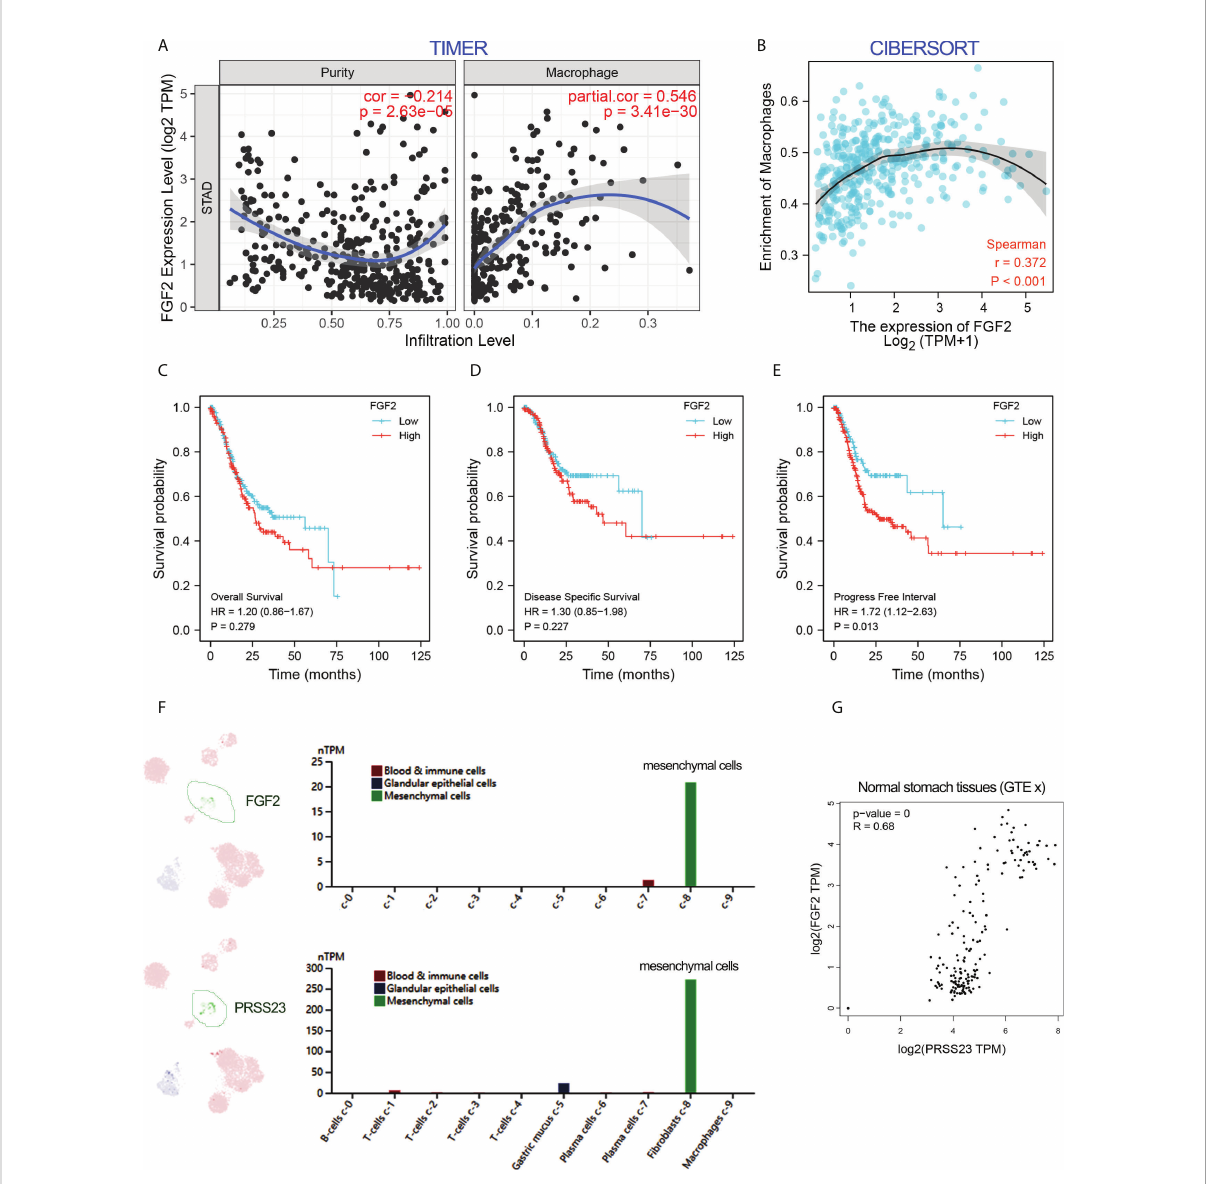
FIGURE 6 FGF2 showed a positive association with macrophage in fi ltration and PRSS23 expression. (A, B) The correlation between FGF2 expression and immune in fi ltration was analyzed using TIMER and CIBERSORT methods. (C – E) FGF2 overexpression predicted poor overall survival, disease- speci fi c survival and progress-free survival in GC from TCGA dataset. (F) Single-cell analysis showed that PRSS23 and FGF2 were both highly expressed in mesenchymal GC cells. (G) FGF2 and PRSS23 were highly co-expressed in normal stomach